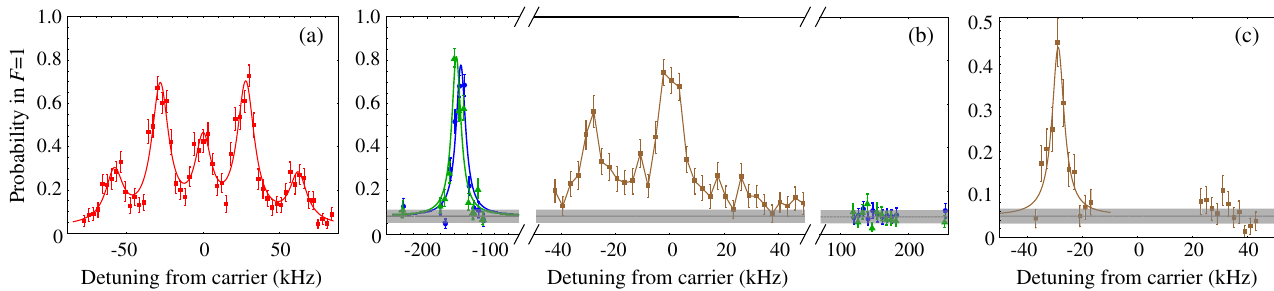
FIG. 3. Axial spectra and 3D ground-state cooling of a single neutral atom. (a) A thermal axial spectrum (red squares) using an intensity corresponding to a cold-carrier Rabi frequency of 12 kHz and a (cid:2) t ¼ 65 - (cid:4) s Raman pulse. The data are fit to Lorentzians (solid line) to guide the eye. (b) Result of simultaneous sideband cooling in three dimensions, demonstrating significant sideband asymmetries and simultaneous ground-state occupations in all dimensions. The axial data (center) illustrate our cooling parameters, and are obtained with a carrier Rabi frequency of 10.6 kHz and a pulse of 236 (cid:4) s (near- (cid:2) pulse on the ground-state (cid:2) n ¼ þ 1 sideband, a 5 (cid:2) pulse on the carrier). For the radial data, the blue circles (green triangles) are spectra along the y 0 ( x 0 ) axis using a 75 - (cid:4) s pulse. The solid lines on the (cid:2) n ¼ þ 1 sidebands are Lorentzian fits. (c) After 3D cooling, axial spectroscopy for a halved carrier Rabi frequency of 5 kHz and a pulse of 450 (cid:4) s . Better spectroscopic resolution affirms a large axial ground-state